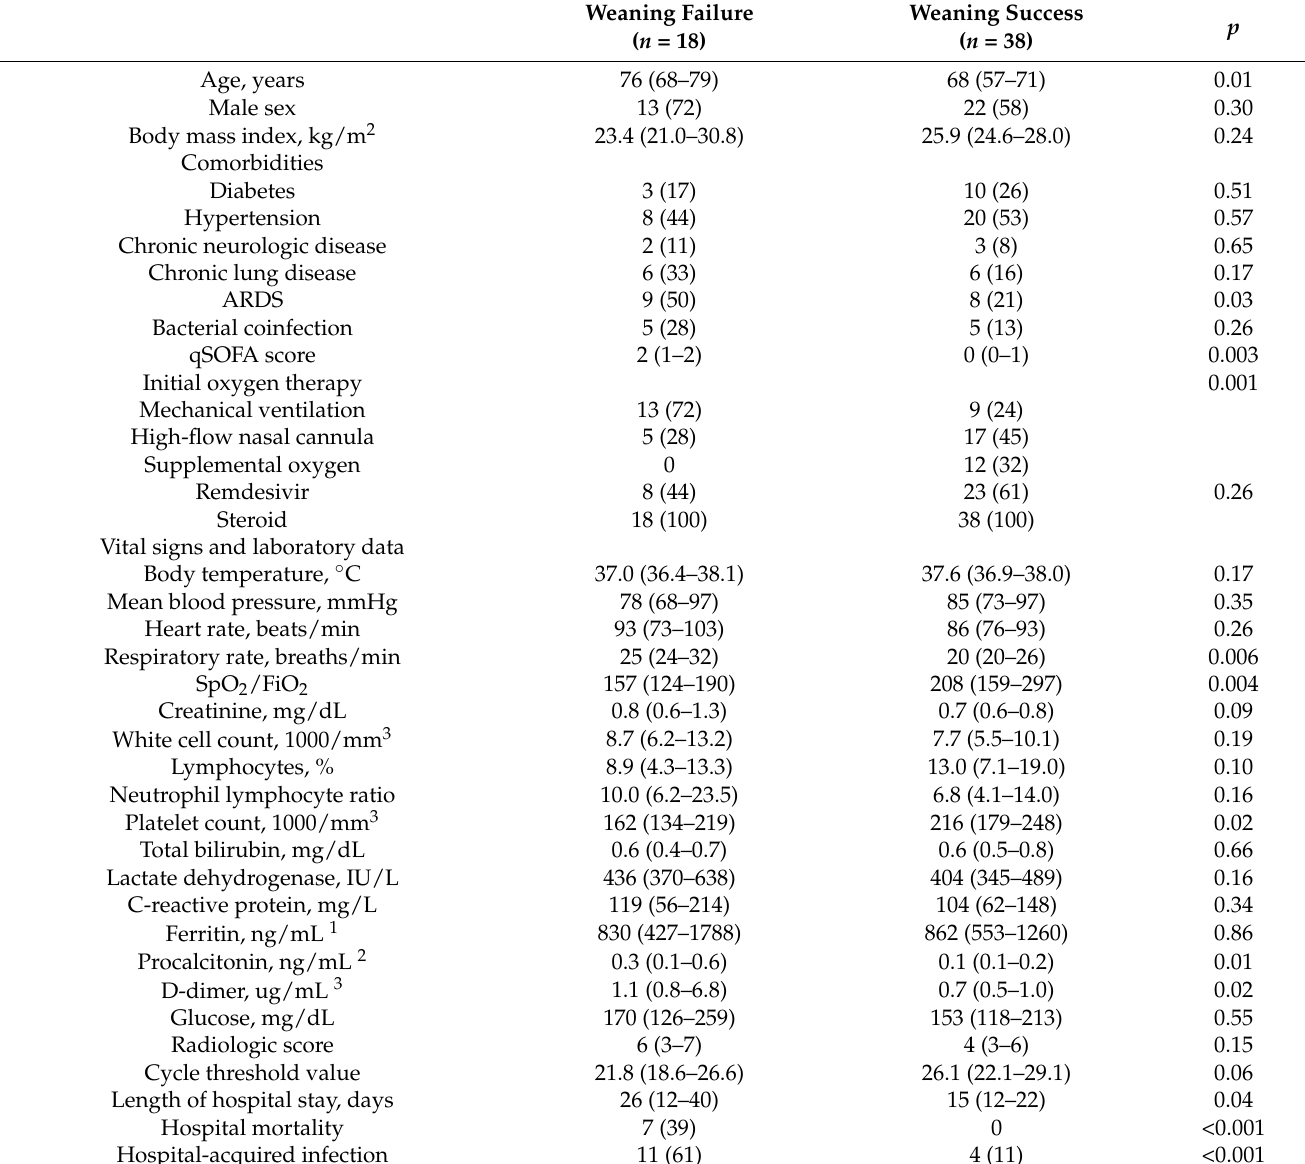
Table 1. Baseline and clinical characteristics of patients with severe COVID-19 according to oxygen therapy status at day 28 following hospital